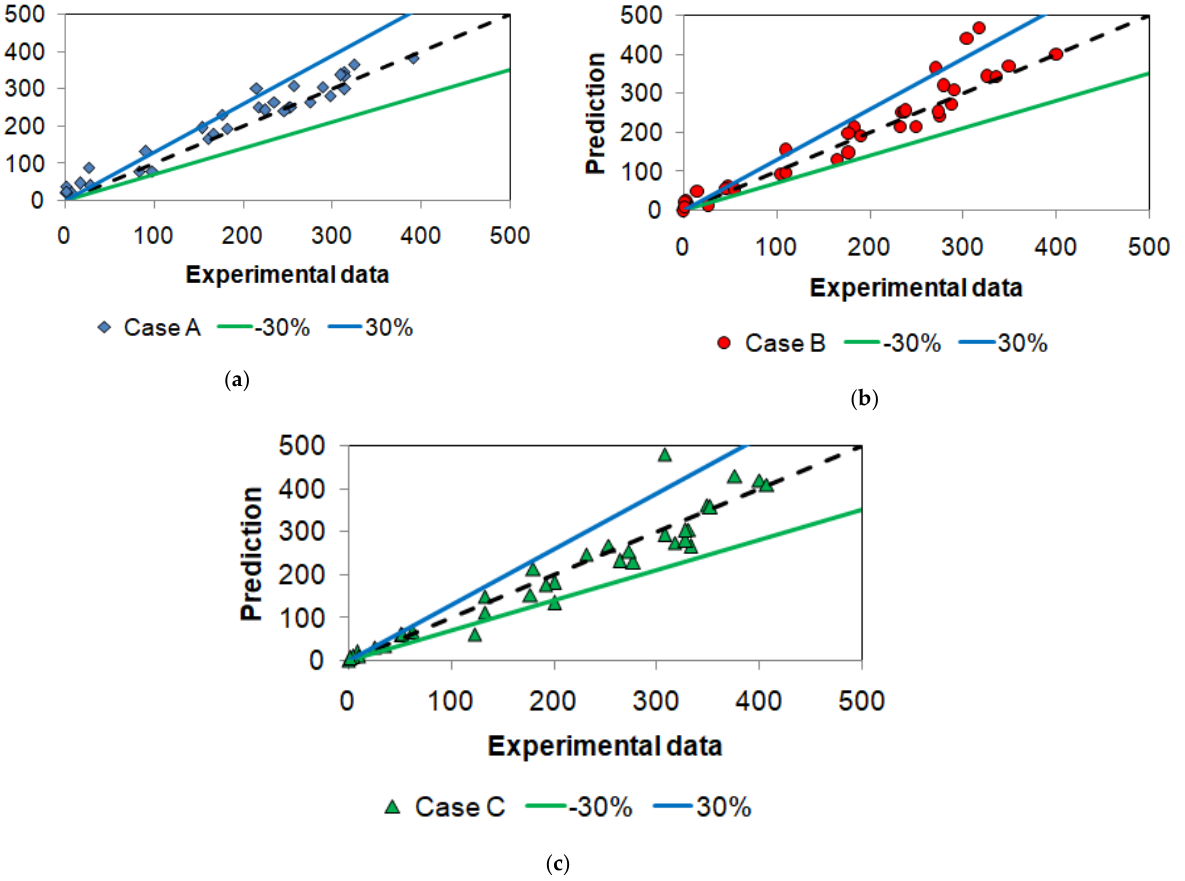
Figure 9. Relationship comparison with existing correlations proposed by Rajaseenivasan and Murugavel [24] for: ( a ) Case A, ( b ) Case B, and ( c ) Case C.